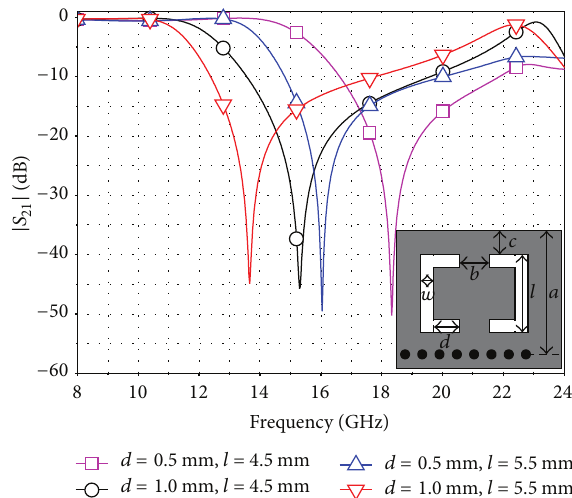
Figure 3: Simulated results of proposed HMSIW-DGS cell with different “ d ” and “ l .” Other geometrical parameters are 𝑎 = 7 mm, 𝑐 = 1 mm, 𝑤 = 0.5 mm, and 𝑏 = 1 mm.